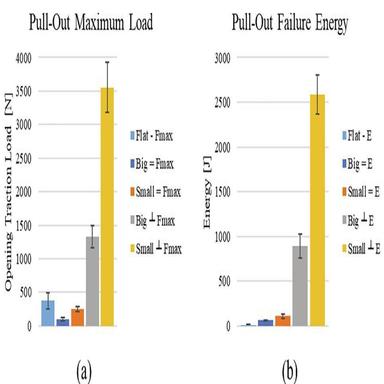
Summary of mechanical properties of the hybrid joints in the different tested configurations; 10a) Maximum Load; 10b) pullout failure energy.